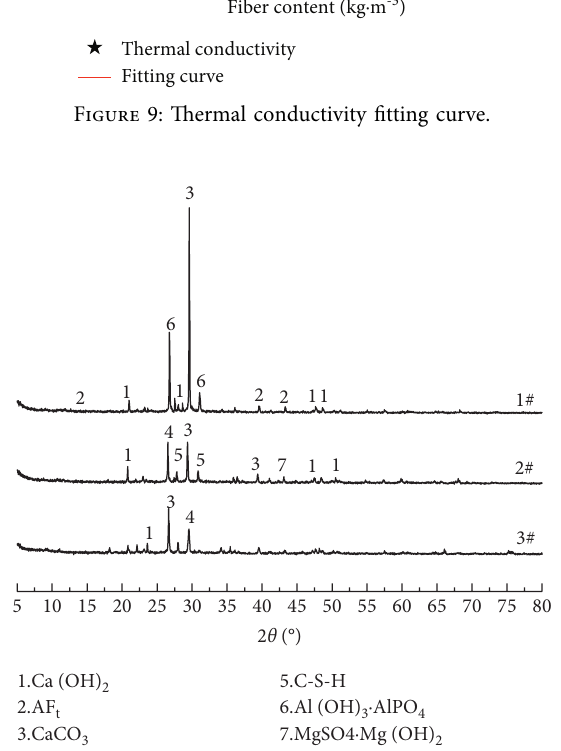
Figure 10: Qualitative analysis of X-ray diffraction results of samples 1#, 2#, and 3#.